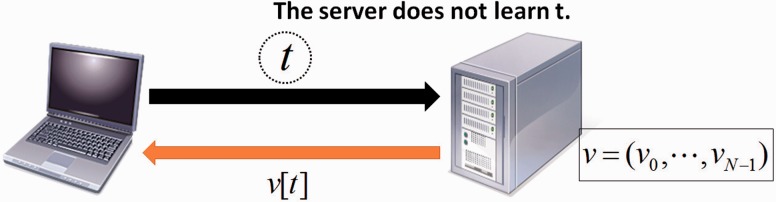
Outline of Oblivious Transfer (OT). The user (laptop computer) obtains tth element of the server’s vector v without leaking t to the server, and none of the other elements of the vector v